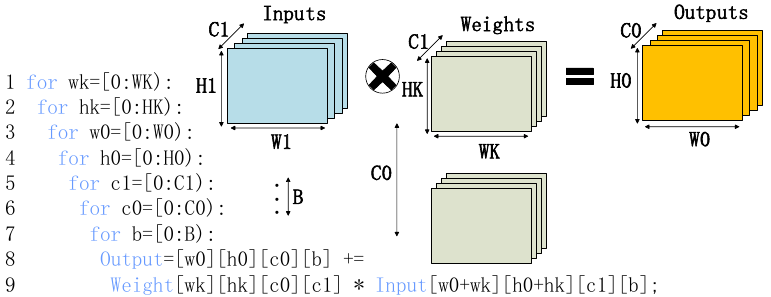
Figure 8. Convolutional layer 7D loop